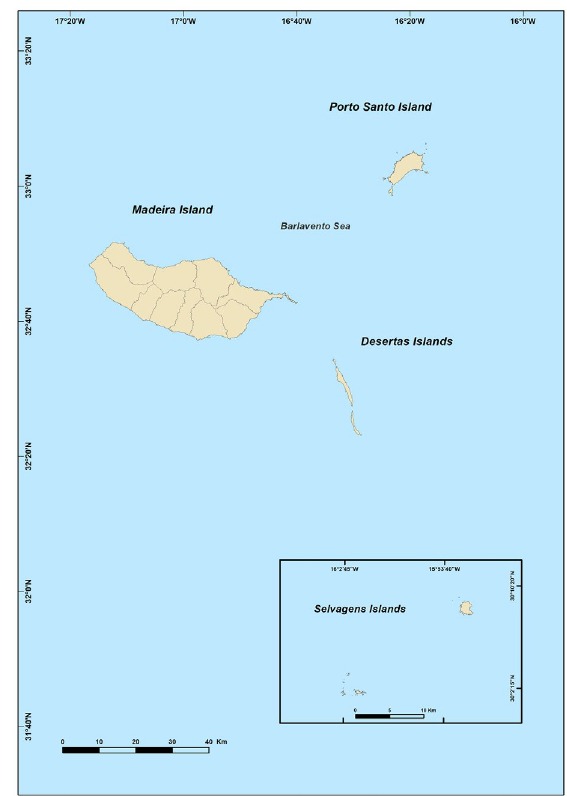
Fig. 1. – Archipelago of